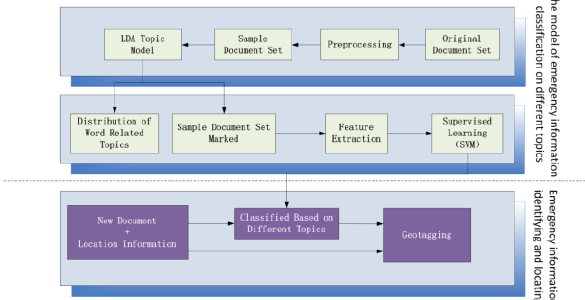
Figure 1. real-time social media text streams classification and location